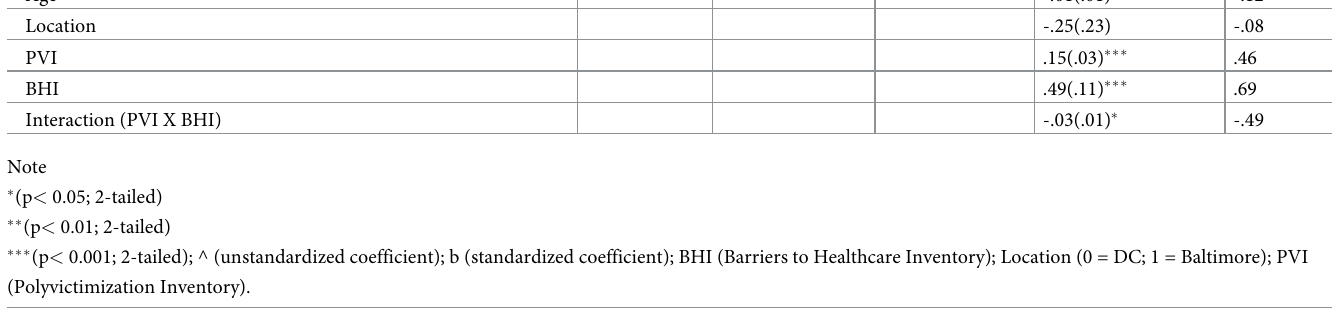
No significant moderating effects were noted between PVI, BHI, and depressive symptoms– and were subsequently not reported in detail in this article. Mediation. Table 6 shows the impact of PVI and BHI on PTSD symptom severity among participants. In step 1, the PVI explained 11.9% of variance in PTSD symptom severity with F (3,147) = 6.6176, p < .001. The findings revealed that PVI positively predicted PTSD symptom severity (b = .3170, P < .001). In step 2, PVI and BHI explained 28.1% variance in PTSD symp- tom severity with F(4, 146) = 14.2746, p < .001.The findings revealed that PVI (b = .2622, p < .001) and BHI (b = .3357, p < .001) positively predicted PTSD symptom severity. The regres- sion weights for PVI subsequently reduced from Model 1 to Model 2 (.3170 to .2622) but remained significant which confirmed the partial mediation. More specifically, PVI has a